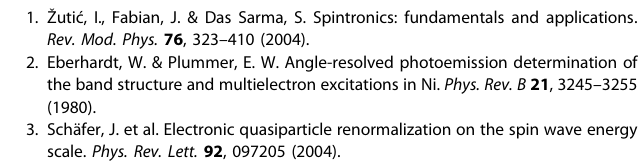
The parameter Δ v ensures the conservation of the particle number, and Δ x enforces the Goldstone condition in the magnon excitation spectra (negative sign corresponds to reduced exchange splitting). See text for